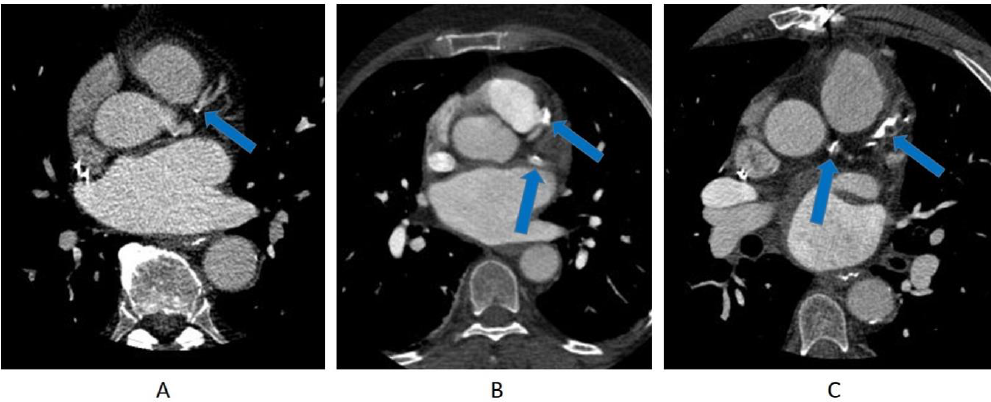
Figure 1. Coronary artery calcification detection on computed tomography (CT) pulmonary venograms. ( A ) Mild coronary calcification, seen as a spot of calcification in the proximal left anterior descending artery. ( B ) Moderate coronary calcification, seen as a bulky calcification in the proximal part of the left anterior descending artery. Another area of calcification is seen in the proximal part of the left circumflex artery. ( C ) Severe coronary calcification, seen as a very dense and long segment of the proximal and mid-portion of the left anterior descending artery. Additional coronary calcification is seen involving the left main coronary artery.